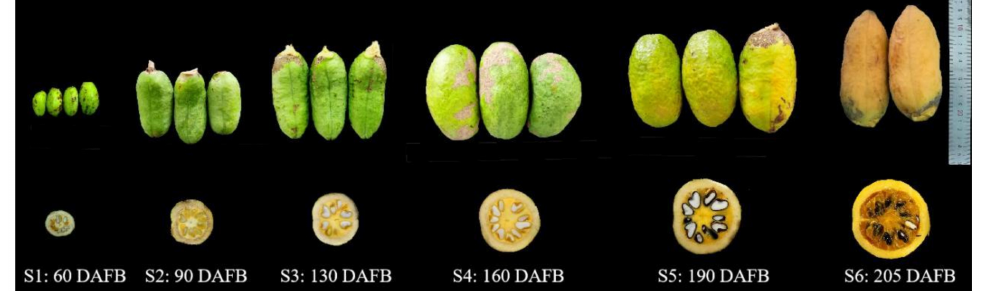
Figure 2. The fruits of Stauntonia obovatifoliola subsp. urophylla at different maturity